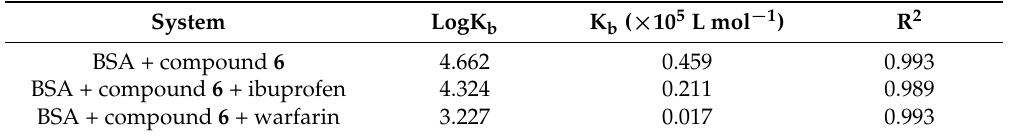
Table 5. Binding constants of BSA with compound 6 in the presence of site markers in Tris-HCl buffer (pH = 7.4) at room temperature.